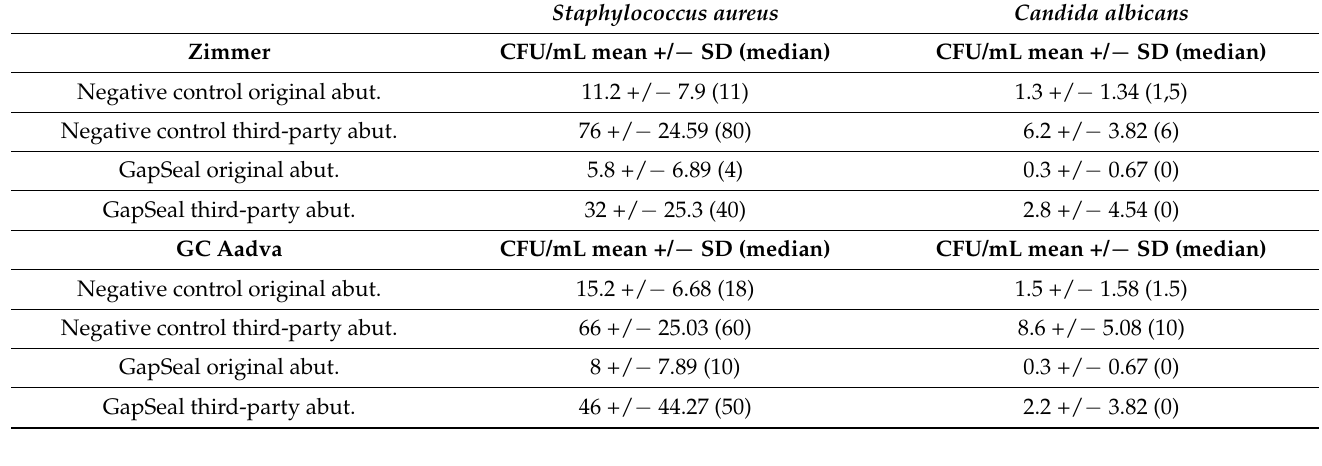
Table 5. Mean counts of Staphylococcus aureus and Candida albicans detected on the internal surface of the implants depending on the abutment fabrication method (original and third-party) and the need for the use of the gap sealing material.